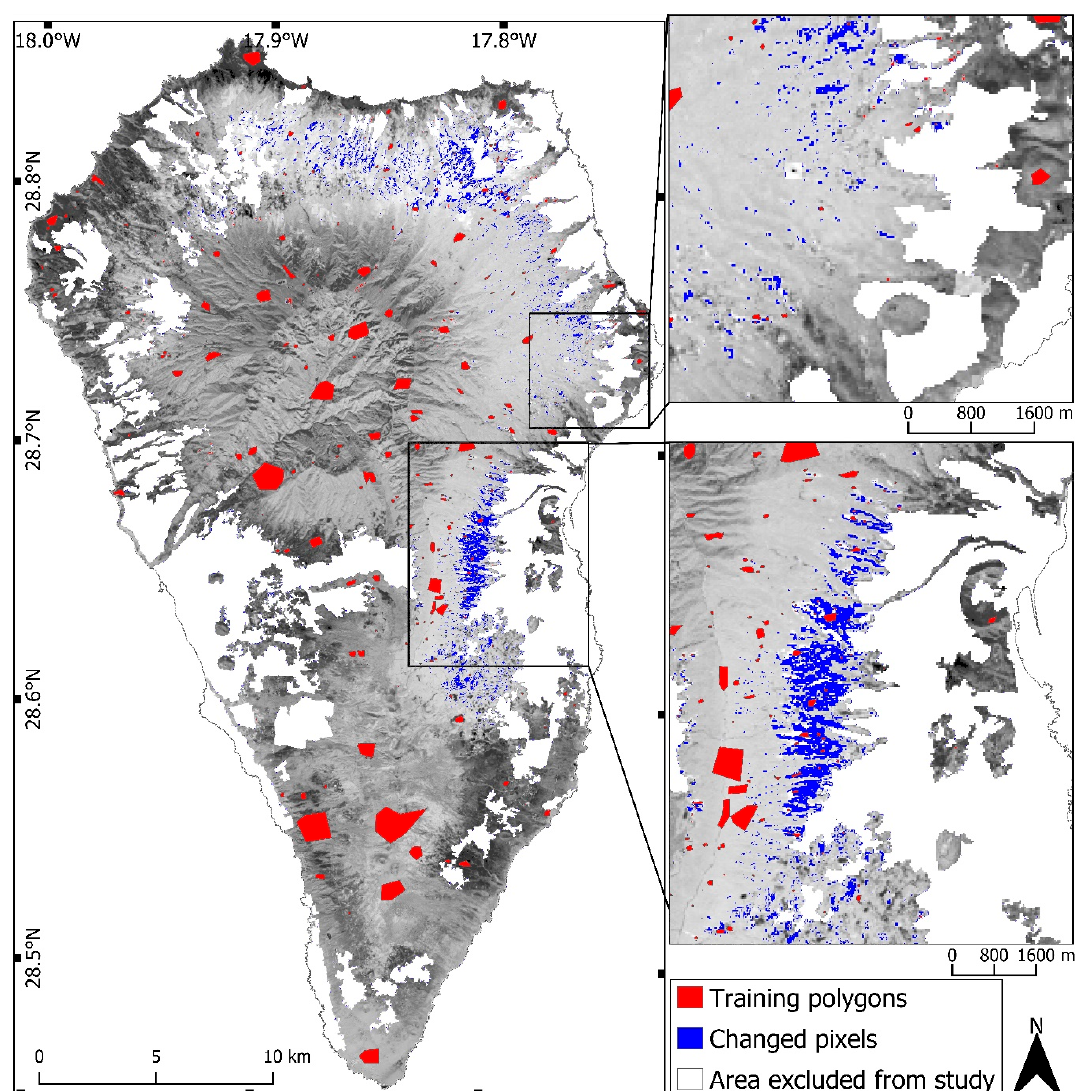
Figure 2. Changed pixels (proxy for leaf on / leaf o ff ) between March 2017 and July 2017 in the Landsat 8 image obtained from the image regression and image di ff erentiation, grayscale raster composite, red-NIR, red, green, each band with 1 / 3 saturation. Blue colour highlights changed pixels between those dates. Training polygons (red) are the training samples used to discriminate between changed and unchanged pixels. Settlements and other intensive human land-uses were cropped out (shown in